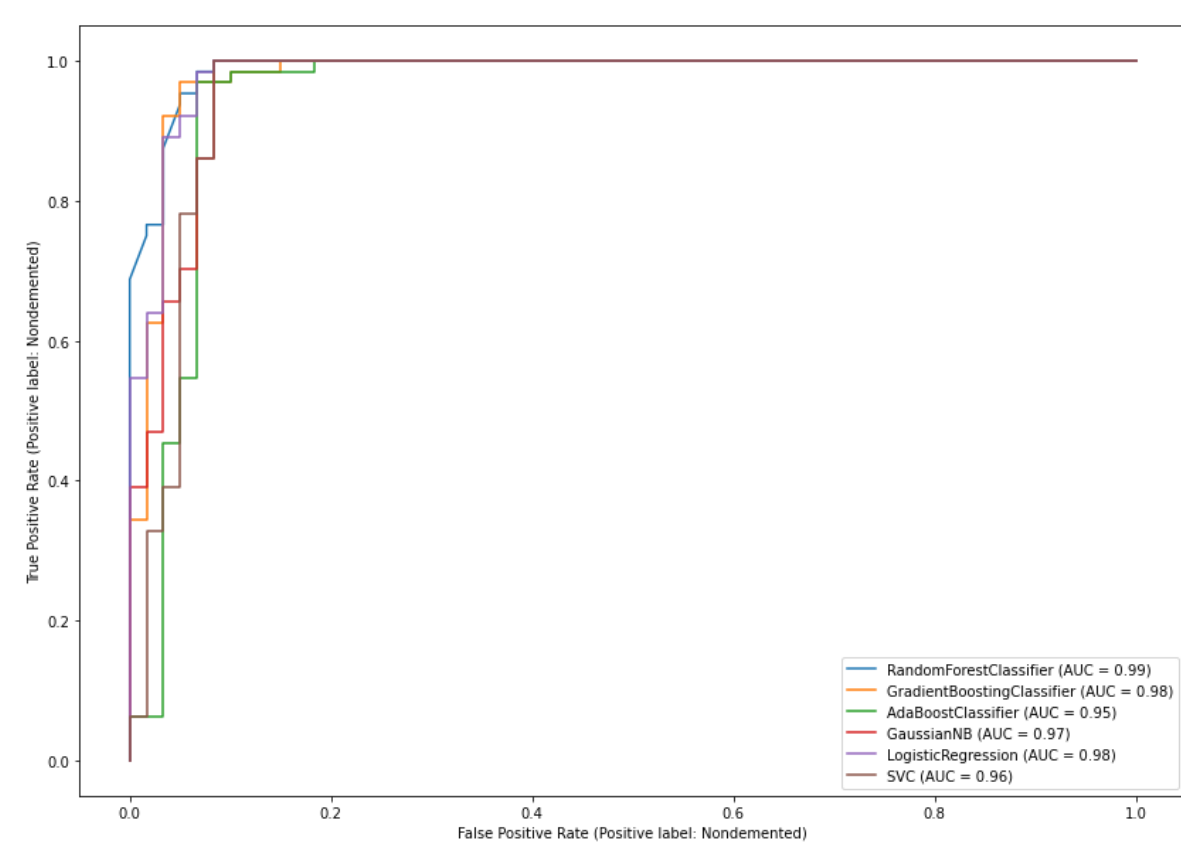
12 of 16 Table 5. Performance results of binary classification of each classifier. N